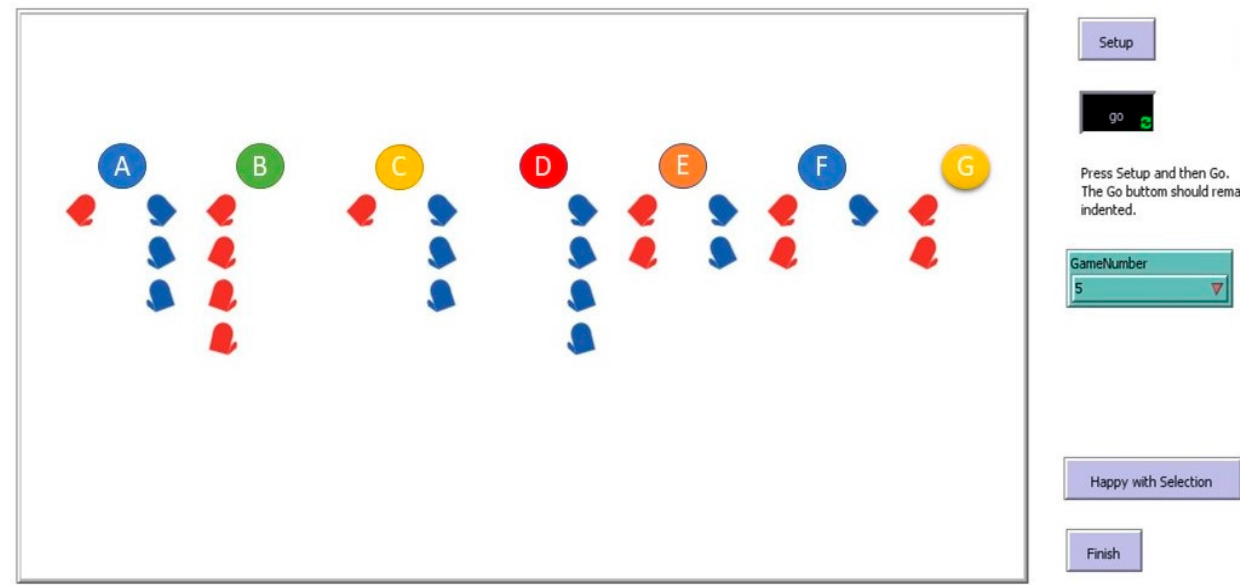
Figure 3. Graphical User Interface (GUI) used in the simulation. The players are represented by alphabetic circles. The colors of the circles represent the current coalition of the players.